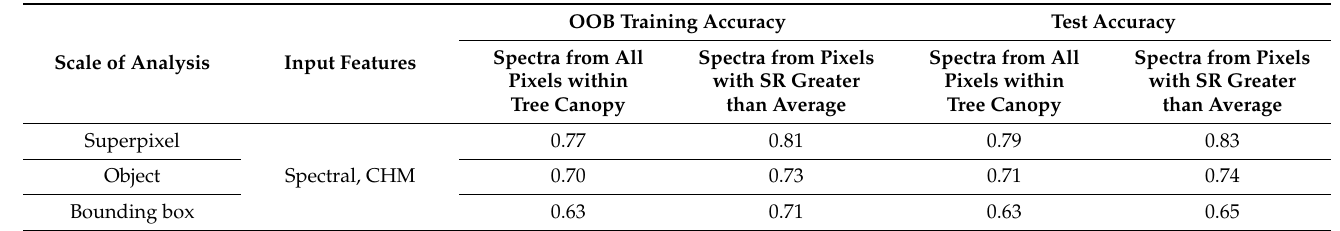
Table 4. OOB training and test accuracies with all 7 classes using the two different sets of spectra.